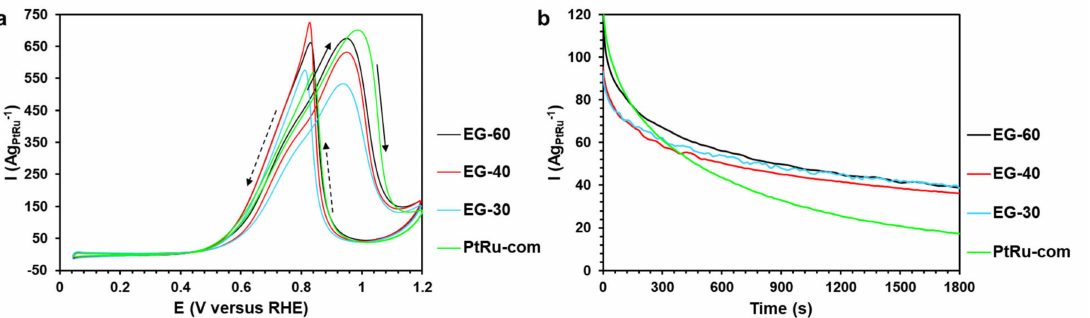
Figure 5. ( a ) Cyclic voltammograms of the PtRu/C materials. The potential sweep rate is 20 mVs − 1 . The electrolyte is 0.5 M CH 3 OH + 0.1 M HClO 4 saturated with Ar under atmospheric pressure. ( b ) Chronoamperograms at 0.6 V for 1800 s of the PtRu/C bimetallic alloys in the 0.5 M CH 3 OH + 0.1 M HClO 4